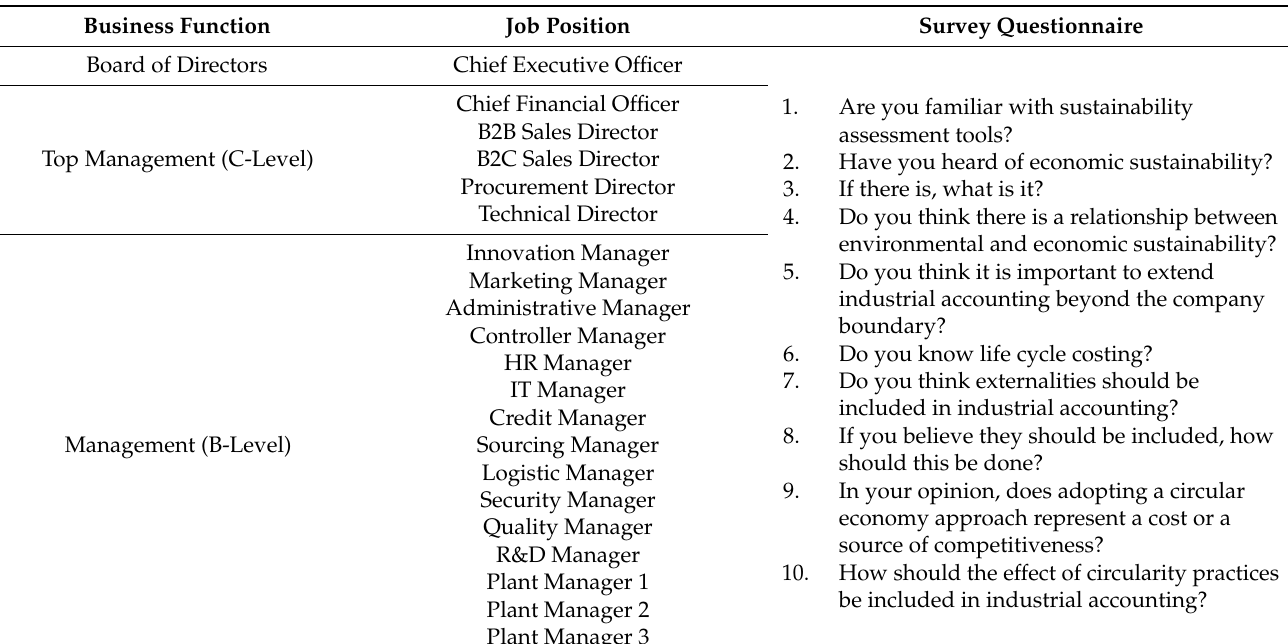
Table 1. Framework for carrying out the interviews (modified based on [67]). Job Position Survey